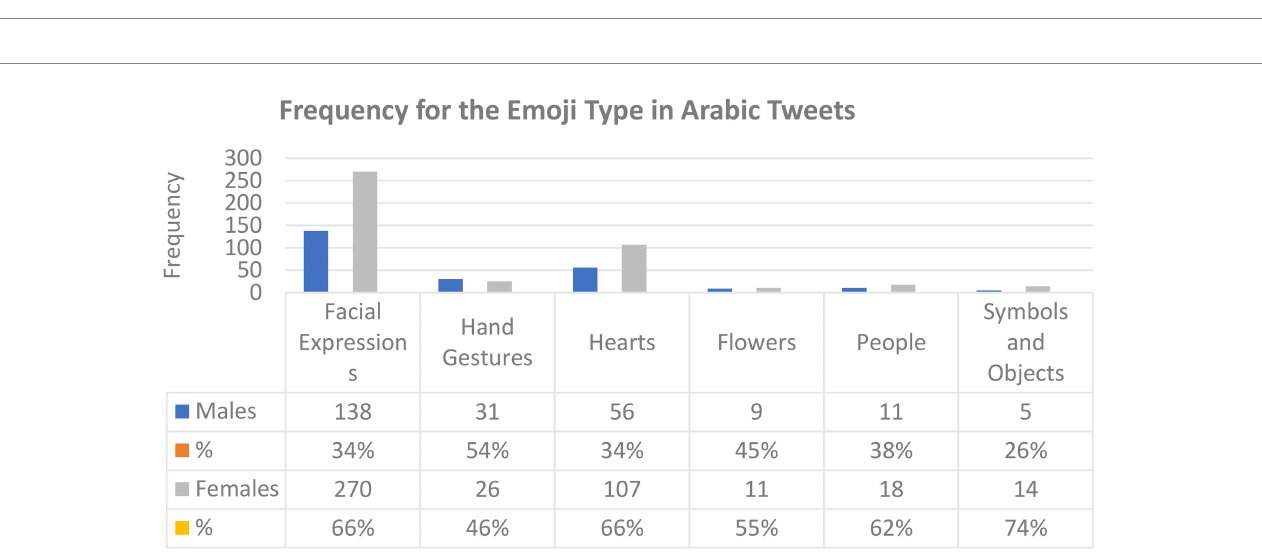
FIGURE 2 The frequency of use by emoji type in Arabic